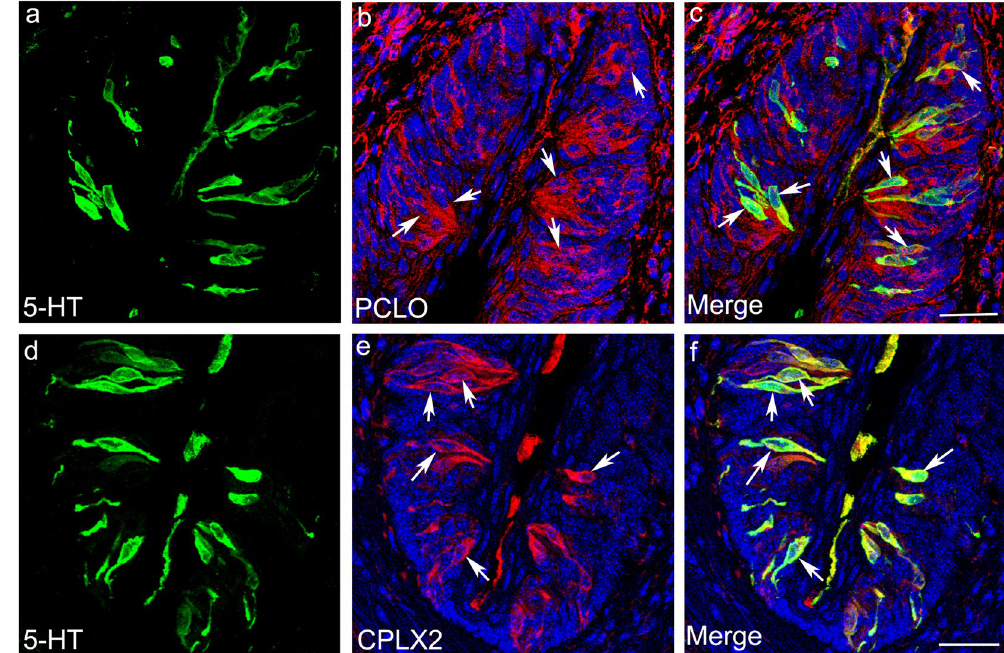
Figure 5. Expression of synaptic components in type III taste cells. Immunostaining was used to identify synaptic components PCLO and CPLX2 (red, a , d ) and the type III marker 5-HT (green, b,e ). Merged images ( c,f ) indicate that PCLO is expressed in almost all 5-HT expressing cells in addition to several non 5-HT expressing cells while CPLX2 is expressed exclusively in almost all 5-HT expressing cells. Arrows point to cells co-expressing 5-HT and PCLO or CPLX2. Scale bars: C = 20 µ m, F = 40 µ